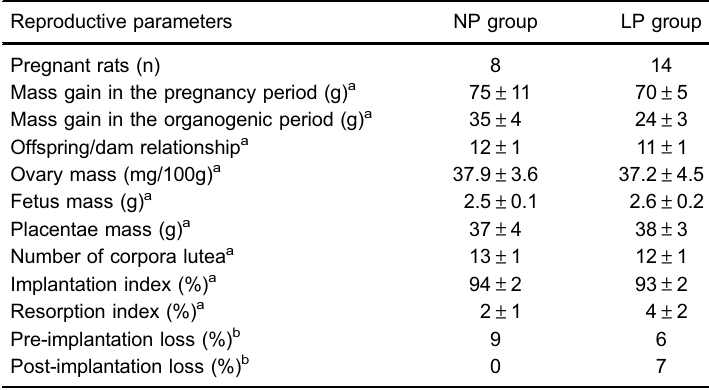
Table 4. Reproductive parameters of female rats subjected to a normal- (NP group, 17% protein) or low-protein diet (LP group, 8% protein) during pregnancy. Reproductive parameters